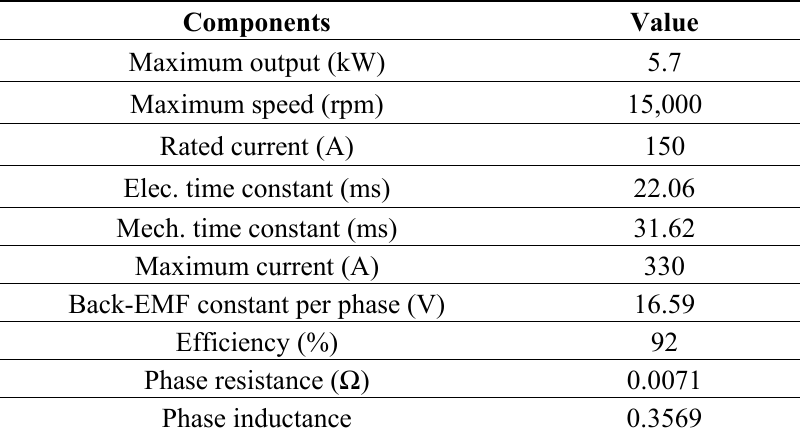
Table 1. Specifications of